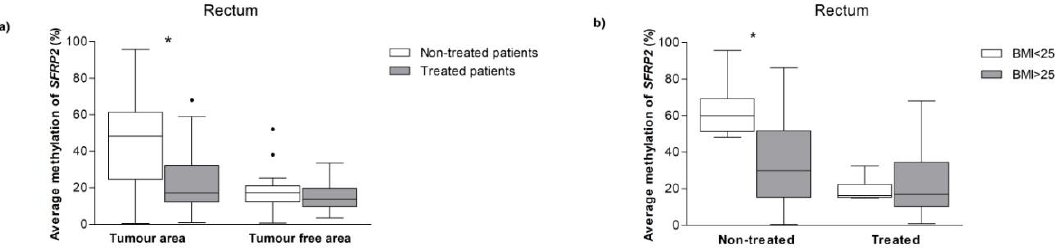
Figure 3. Analysis of abdominal location and therapy of CRC on the SRFP2 methylation. Analysis of location and CRC patients treated on SFRP2 methylation status. Methylation levels of the SFRP2 divided by the treated versus the non-treated patients in areas with tumor and in tumor-free areas ( a ), and rectum separated by BMI in the treated versus the non-treated patients only in the samples with tumors ( b ). Mann-Whitney U-test was performed to compare the means. Abbreviations: SFRP2 —Secreted frizzled-related protein type 2; BMI—body mass index. Table 3. Multivariateregressionanalysisof SFRP2 methylationlevelsaccordingtotheneoadjuvanttherapy. R 2 = 0.280